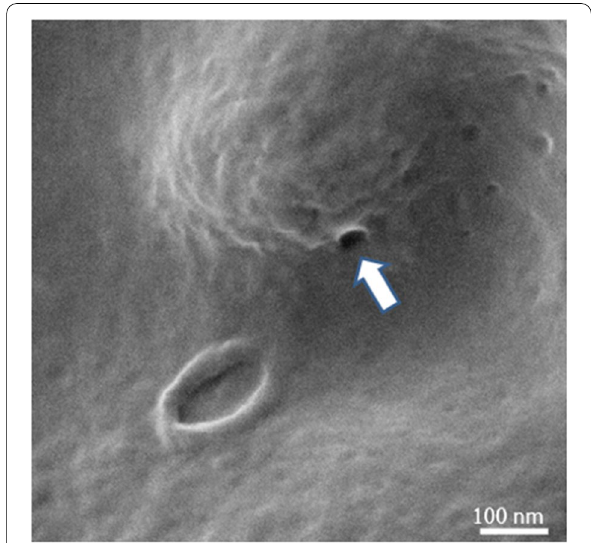
Fig. 9 HIM image of the fine morphology of caveolae (indicated by the white arrow) on the surface of a cell membrane, demonstrating high resolution and deep depth of focus. Figure modified from [51]